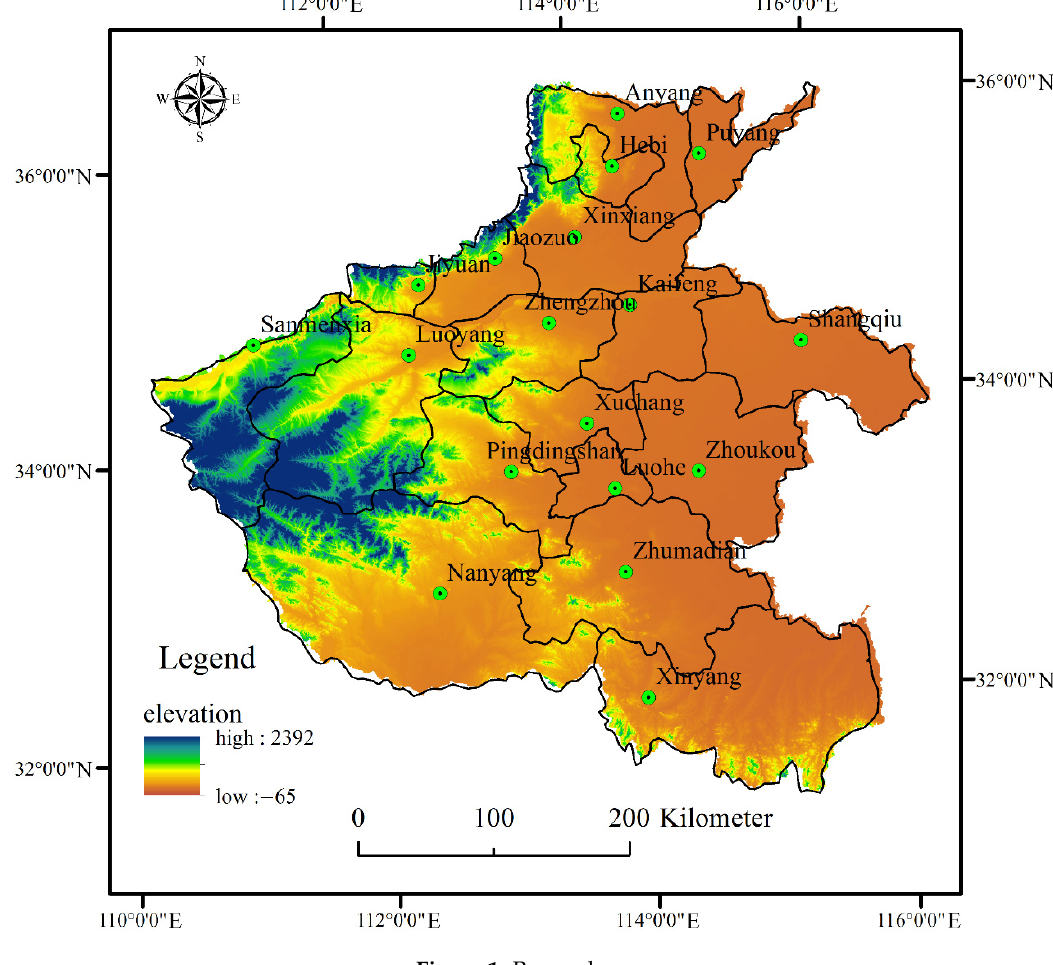
Figure 1. Research Figure 1. Research area.